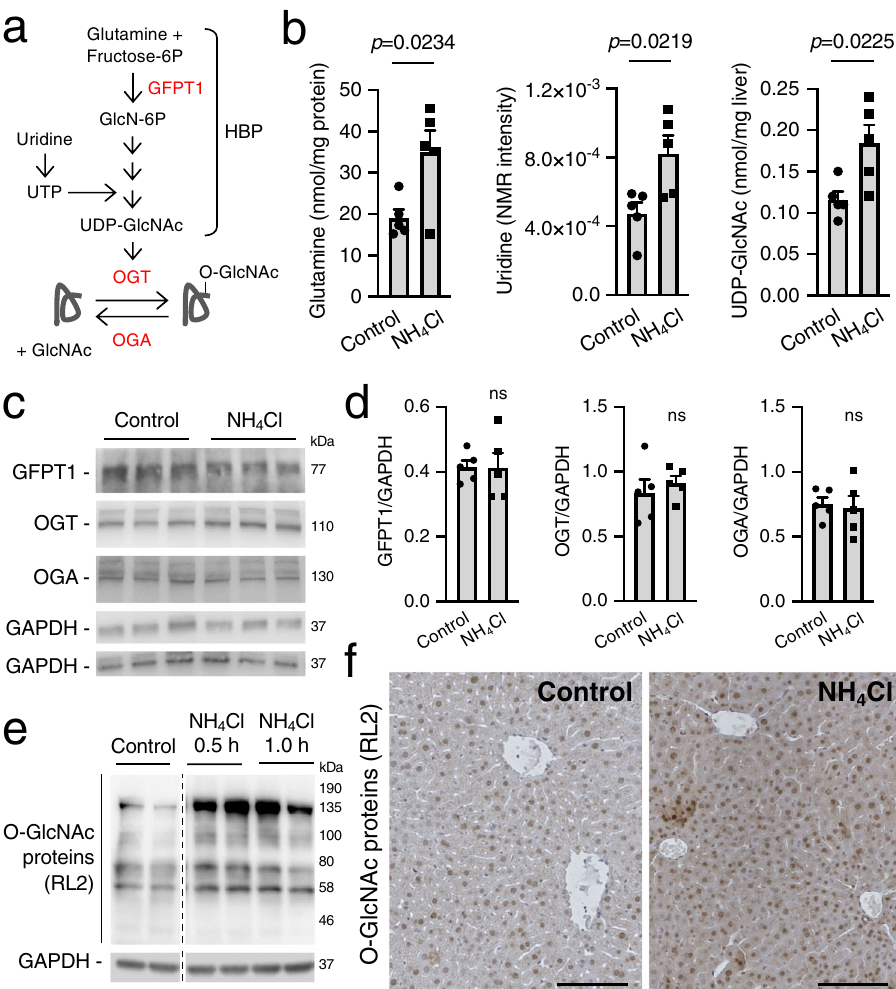
Fig. 1 | Hyperammonemia enhances hepatic O-GlcNAcylation. a Schematic depiction of the HBP and O-GlcNAcylation. Glutamine and uridine feed into the HBP that produces UDP-GlcNAc, while GFPT1 is the rate-limiting step of UDP- GlcNAc synthesis. Protein O-GlcNAcylation is operated by OGT while OGA removes the O-GlcNAc from proteins. b Hepatic content of glutamine, uridine and UDP-GlcNAc in livers of C57BL/6 wild-type (WT) mice at 1.0h after the intraperitoneal (i.p.) injection of ammonium chloride (NH 4 Cl) (10mmol/kg) compared to livers of mice that received i.p. injection of sodium chloride (Con- trol) (n=5 mice/group). p =0.0234, p =0.0219, p =0.0225. (Unpaired t -test). c , d Western blots anddensitometric quanti fi cationsof GFPT1, OGTandOGA in livers